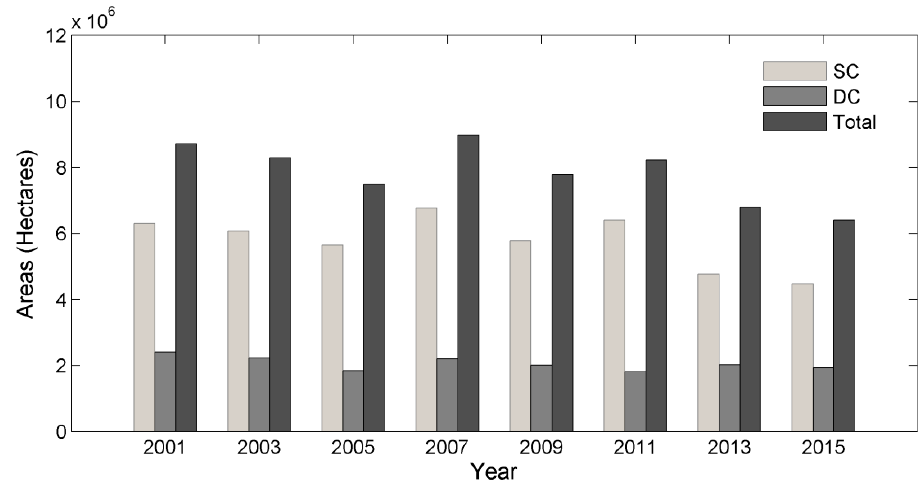
Figure 9. The crop areas of Hubei Province.